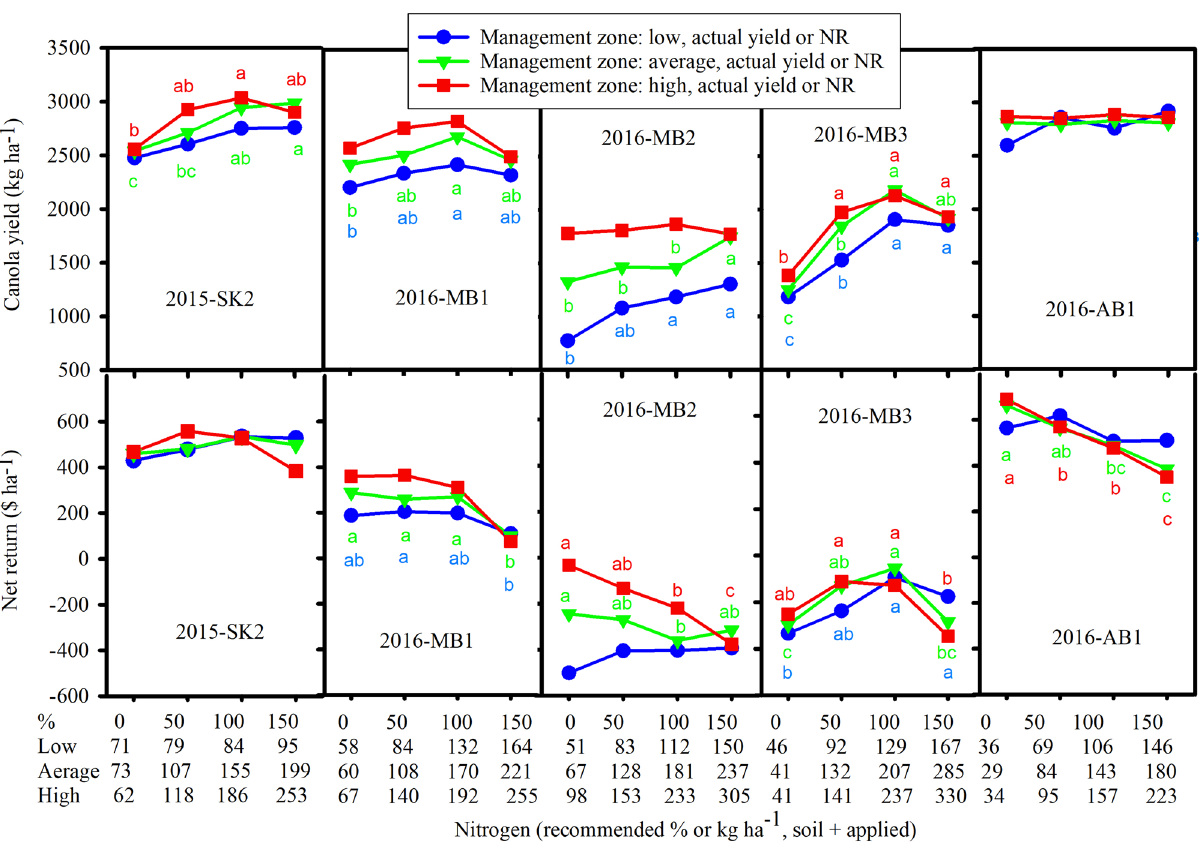
Figure 3. Response of canola yield and net revenue to nitrogen fertilizer treatments in three canola management zones at 2015-SK2, 2016-MB1, 2016-MB2, 2016-MB3 and 2016-AB1. Means followed by the same letters for each canola management zone are not significant ( p > 0.05) (SigmaPlot, vision 14, https ://systa tsoft